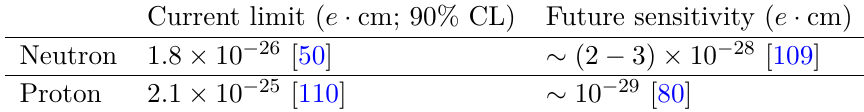
Table 2 . The current limit and future sensitivity of nucleon